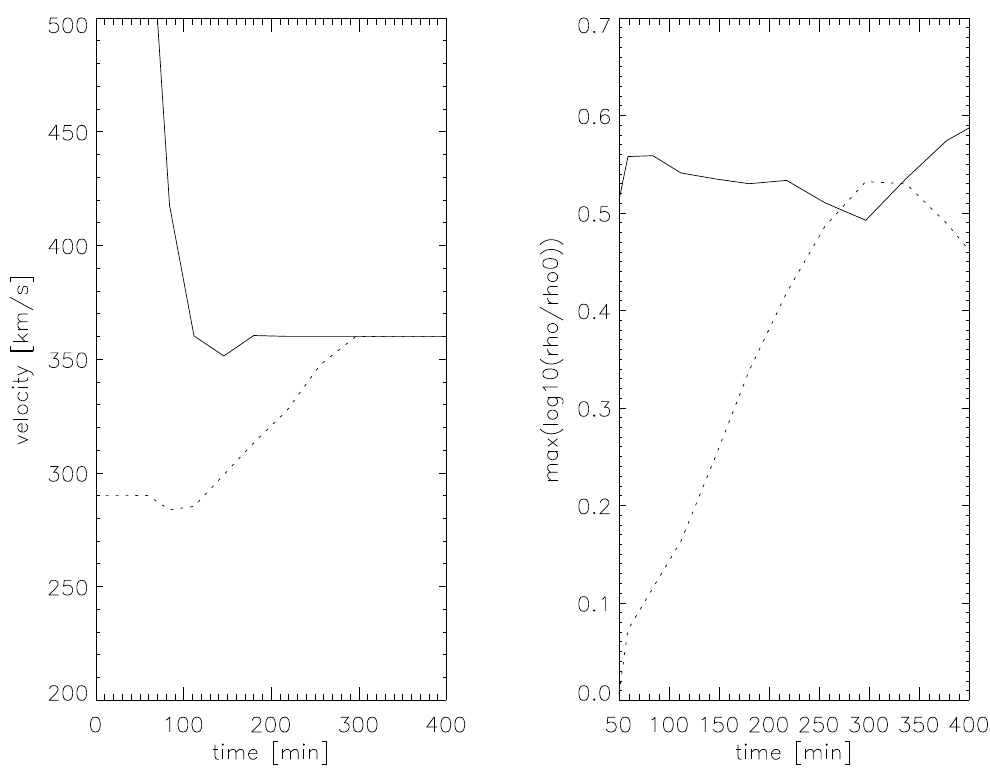
Fig. 3. The velocity (left panel) and shock-strength of the forward shocks (right panel) as a function of time for the fast (solid line) and the slow (dotted line) CMEs presented in Figs. 1 and